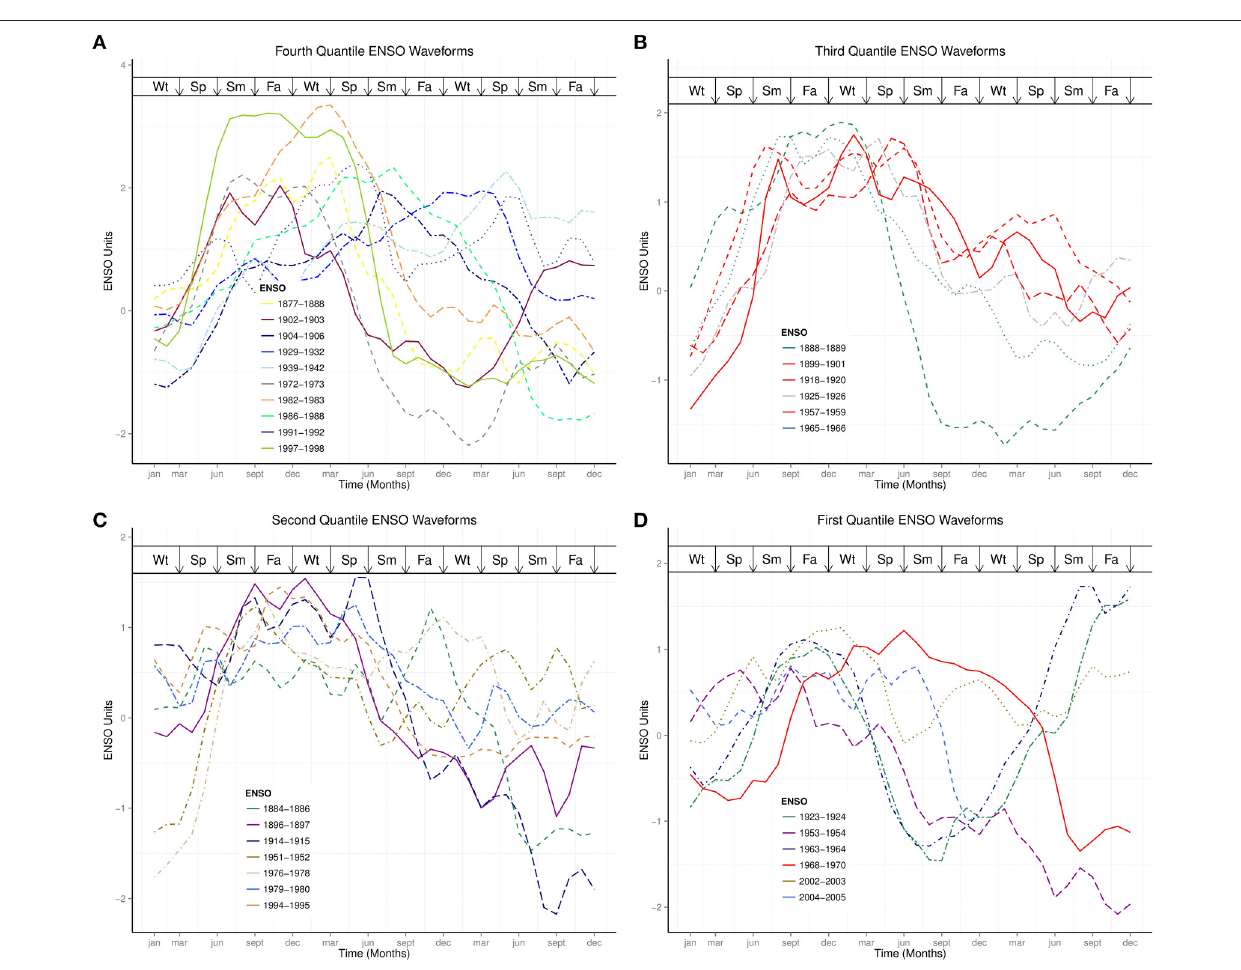
Frontiers in Environmental Science |